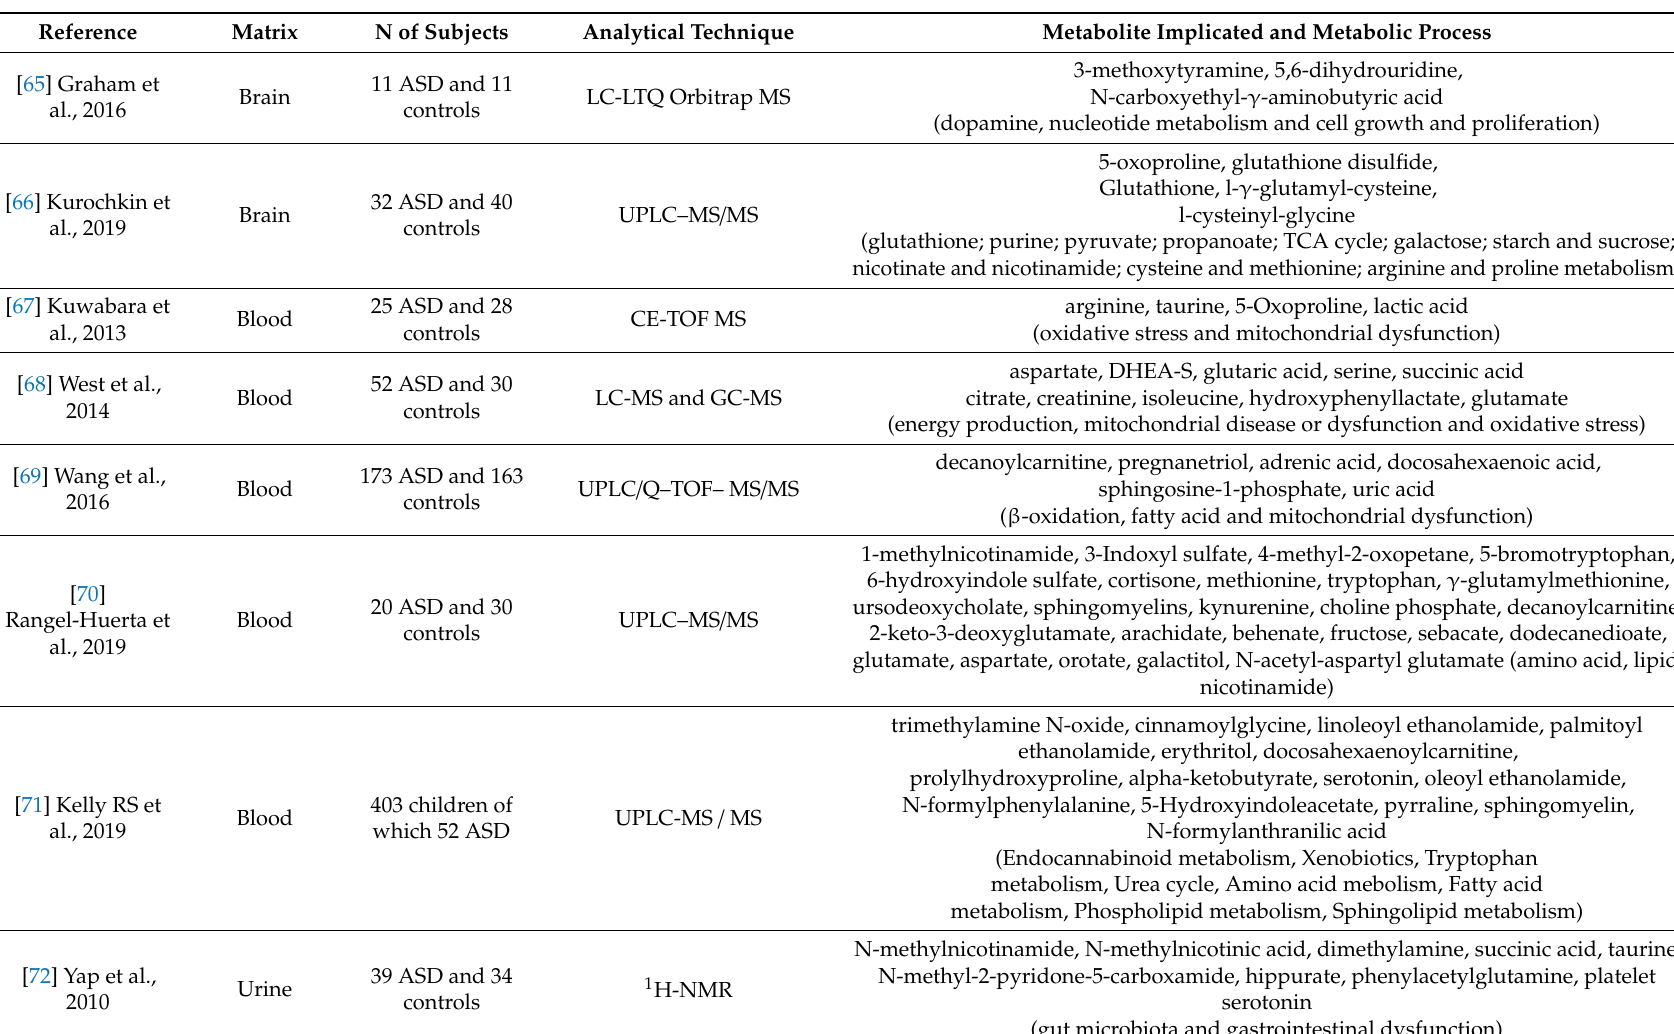
Table 2. Metabolomics-based targets of